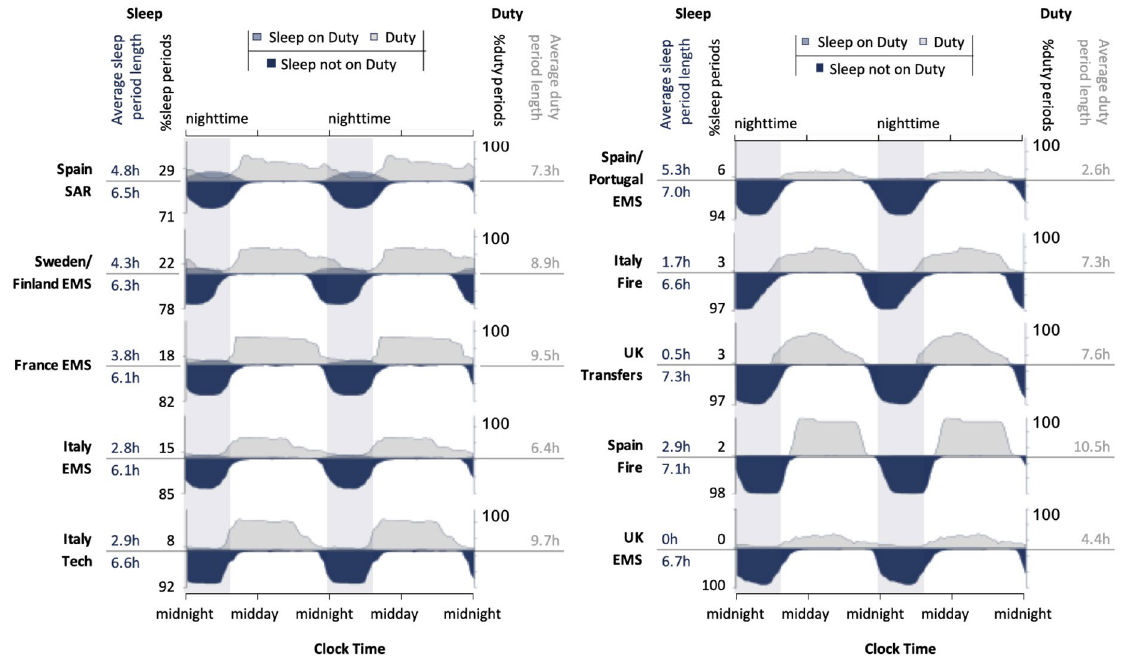
Figure 3. Work and sleep distributions vary as a function of location and type of operation. To characterise patterns of work and sleep, the 24 h distributions were double plotted. duty and sleep periods were expressed as a percentage of the total number of periods at that time of day (in 15-min bins). Sleep periods that were associated with duty were plotted, superimposed over duty, with sleep periods outside of duty also